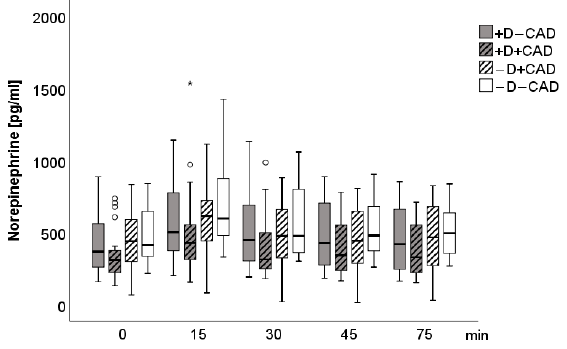
Figure 3. Boxplot of norepinephrine for each measurement time. Circle: ordinary outliner defined as one and a half box-length, asterisk: extreme outliner defined as above one and a half to threefold box-length.